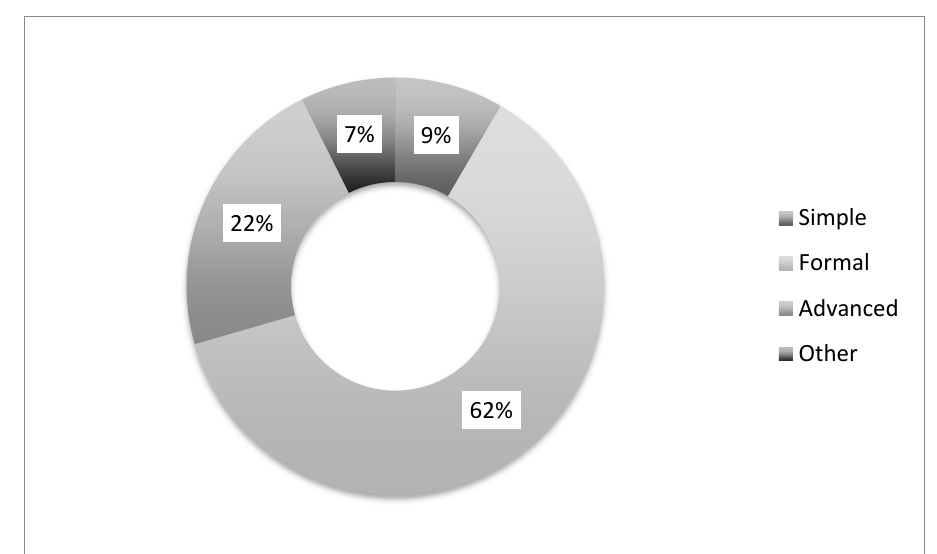
Figure 5. Number of tools found for different categories.